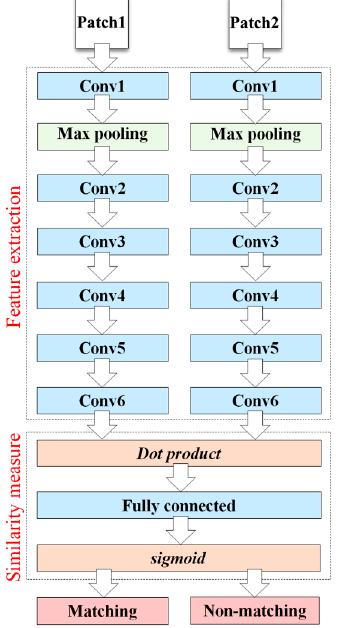
Figure 1. Architecture of Siamese convolutional neural network.